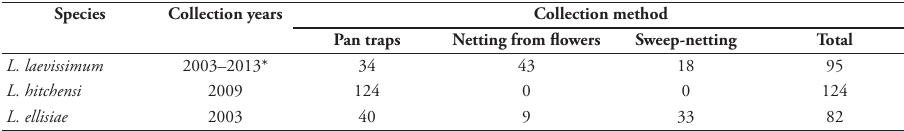
Table 1. Numbers of pinned specimens used for examining female social